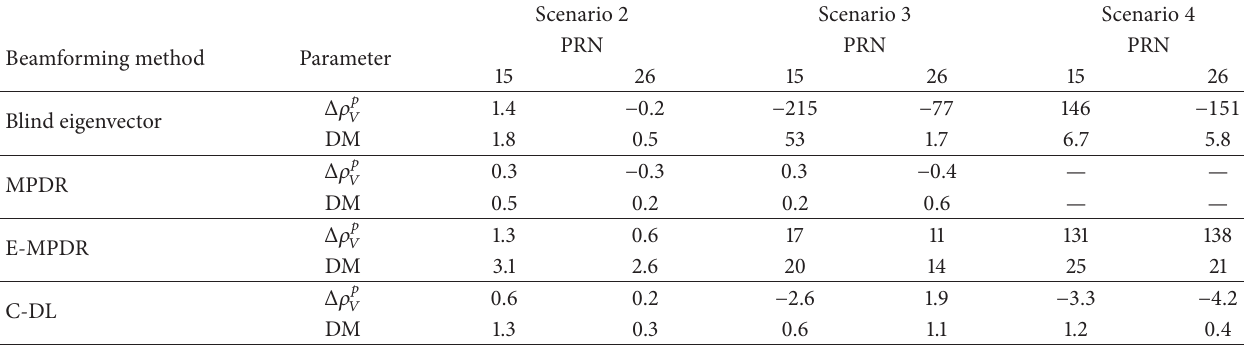
Table 11: Distortions: for one CW, two CW + one WB, and six CW (in meters).